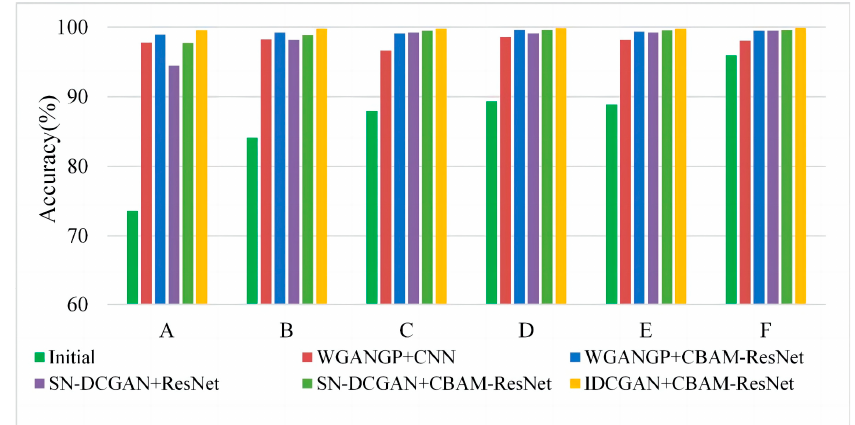
Figure 12. Experimental results based on multi-class imbalanced data.